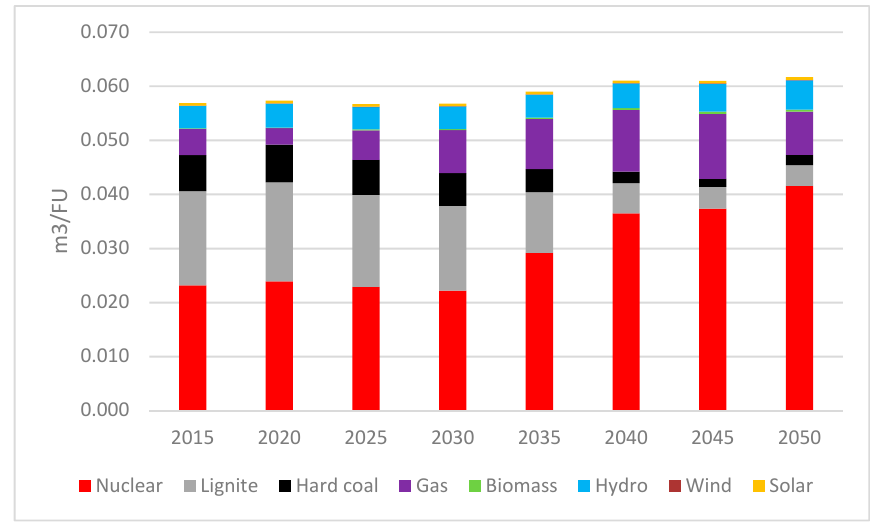
Figure 8. Results of the water footprint from electric vehicles batteries charging in the CR.